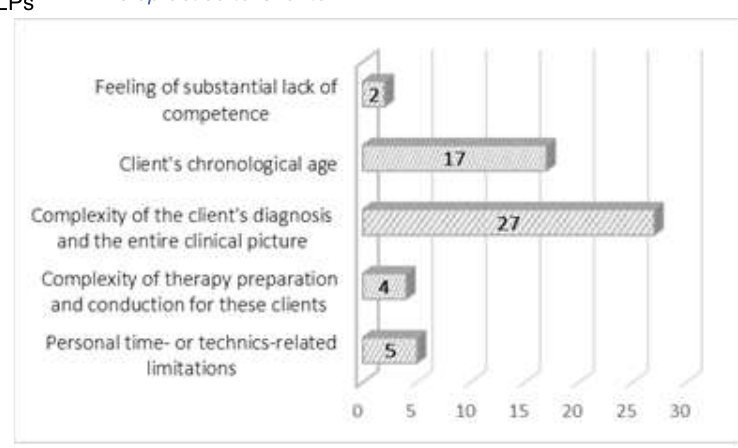
The Frequency (n) of Selected Reasons for Not Offering the Telepractice to